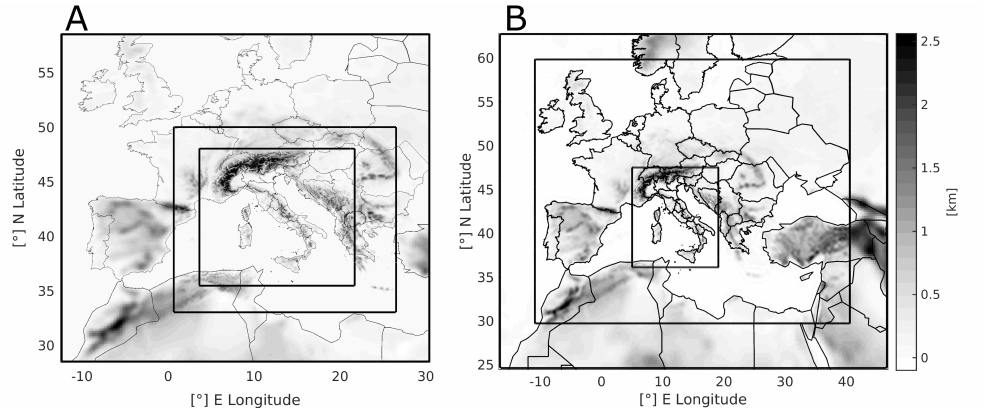
Figure 3. Panel ( A ), the WRF-OL setup: three two-way nested domains with 13.5, 4.5, and 1.5 km grid spacing. Panel ( B ), the WRF-DA setup: three two-way nested domains with 22.5, 7.5, and 2.5 km. Gray shading indicates the model terrain.